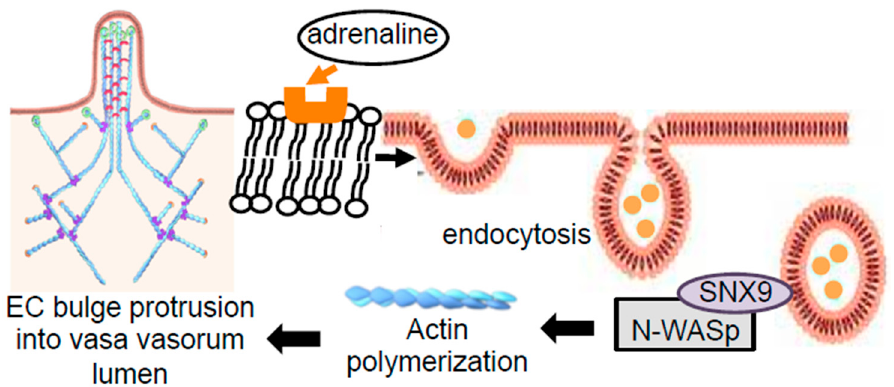
Figure 7. Scheme depicting the proposed mechanism of the endothelial cell (EC) bulge protrusion into the vasa vasorum lumen. In systemic hypertension patients, adrenaline promotes the endocytosis-dependent SNX9–N-WASp interaction that activates the actin polymerization and the EC bulge protrusion into the lumen of the vasa vasorum, resulting in narrowing the lumen of the vasa vasorum.